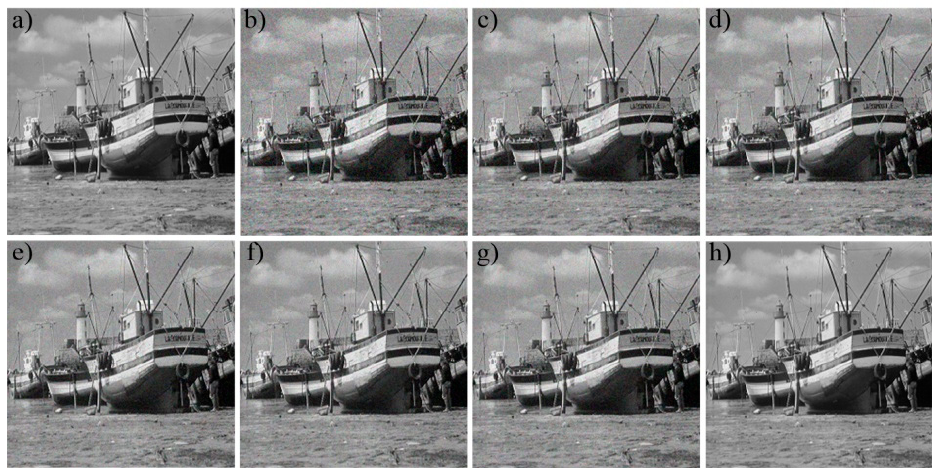
Figure 13. Recovery effect of the six methods on the Cameraman image. ( a ) original image; ( b ) noisy